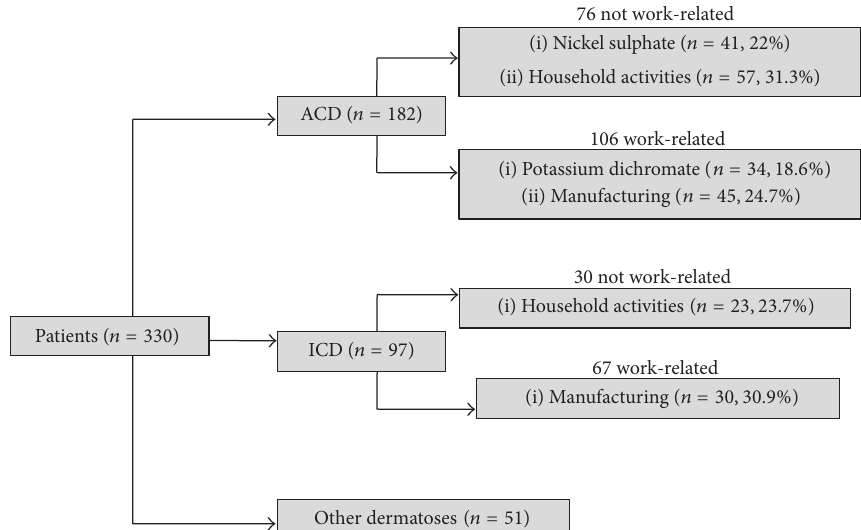
Figure 1: Final diagnosis after determination of clinical